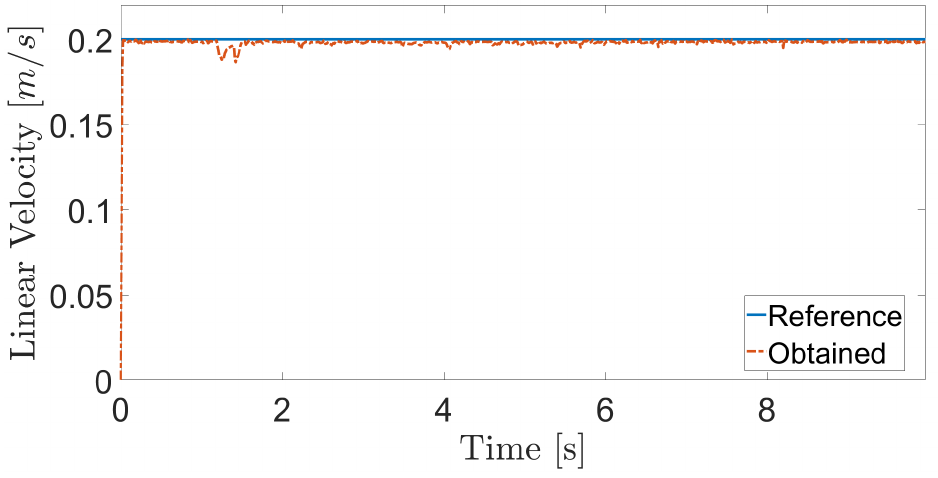
Figure 16. Angular velocity error of the robot when climbing the inner surface of the LPG tank.